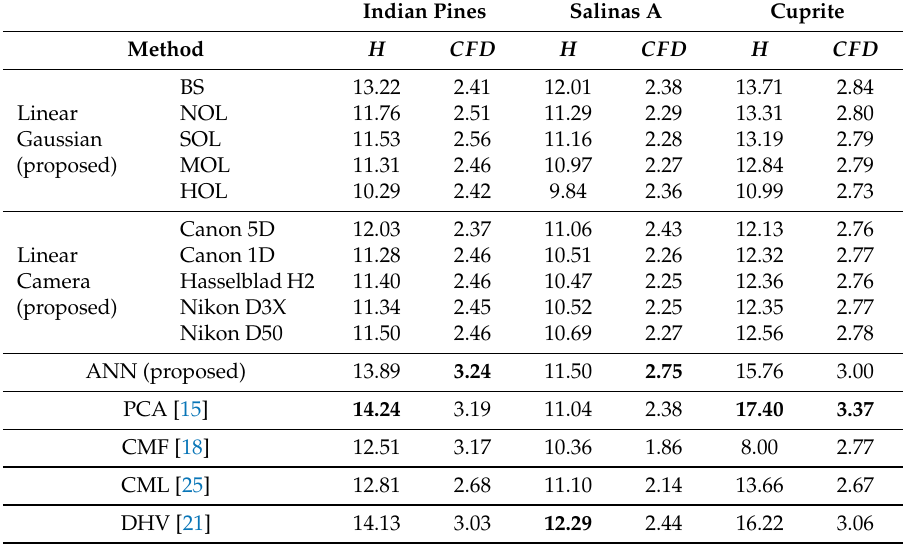
Table 2. Entropy and fractal dimension for the visualization results in Figures 11–13. The values in bold represent the highest values for the respective image.